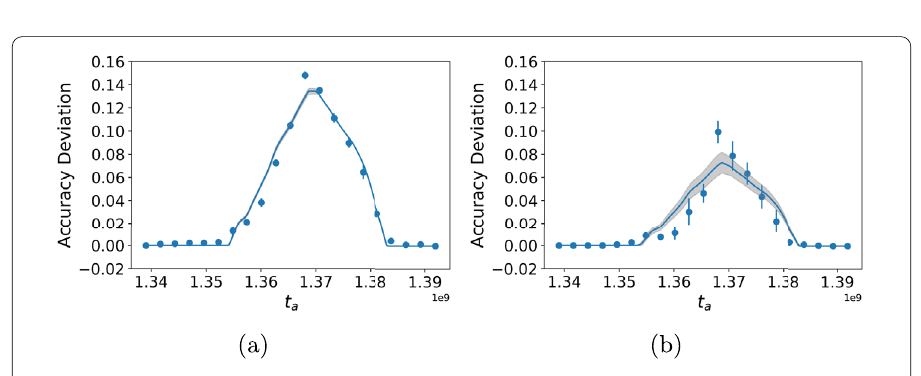
Figure 4 Accuracy deviation curve for KhanAcademy data. ( a ) Using random forest classifier; ( b ) Using a MLP classifier